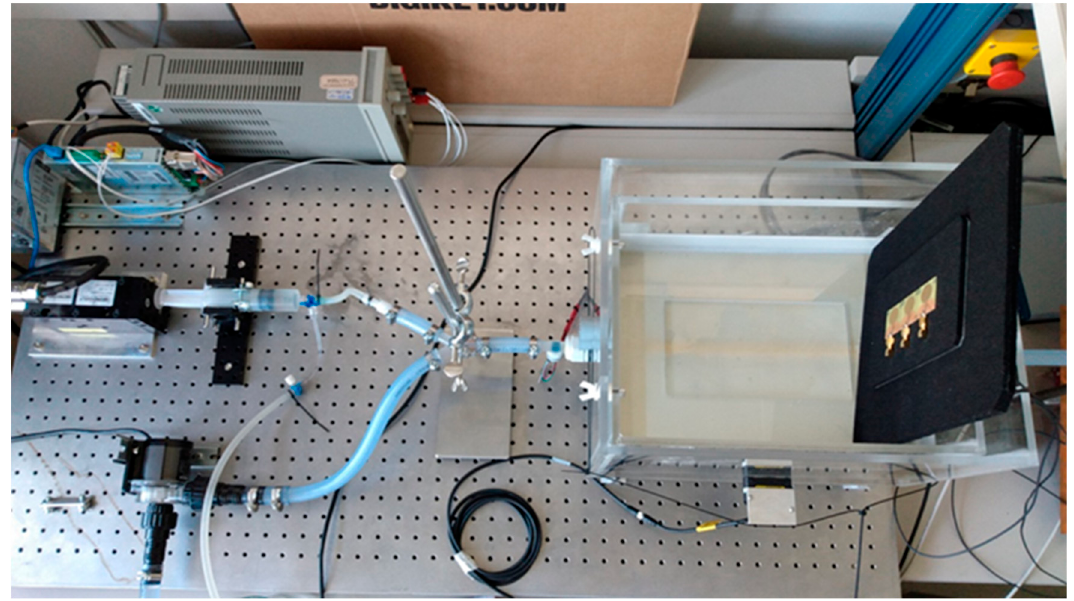
Figure 3. Setup for macroscopic model environment for measurement